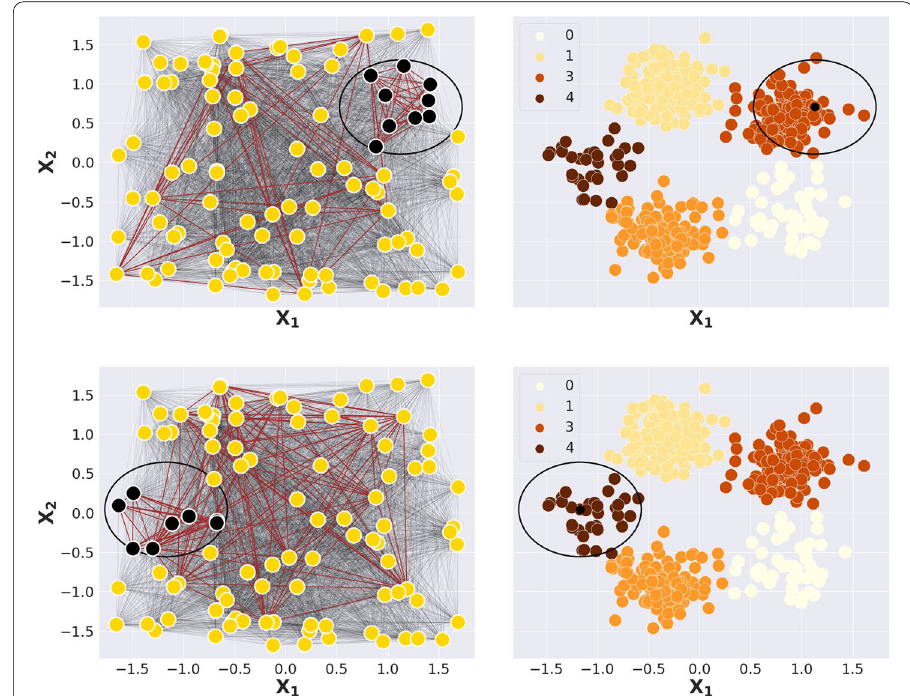
Fig. 4 An illustration of our benchmark data at times a t = 0 , b t = 256 . In both a and b , the left images shows a time-snapshot G 0 and G 256 and the right images are points of the particle in the 5-well potential, which are clustered into 5 sets with k -means. Edges in red color are removed from the graph. Vertices in the circles are considered as patterns characterizing corresponding states